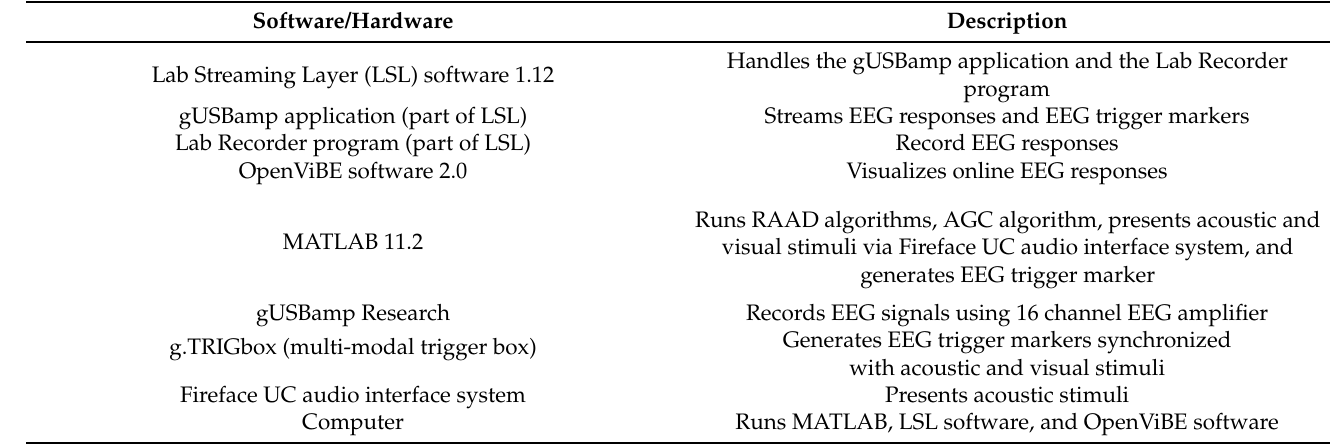
Table 1. Software and hardware used for the proposed cognitive-driven gain controller system.